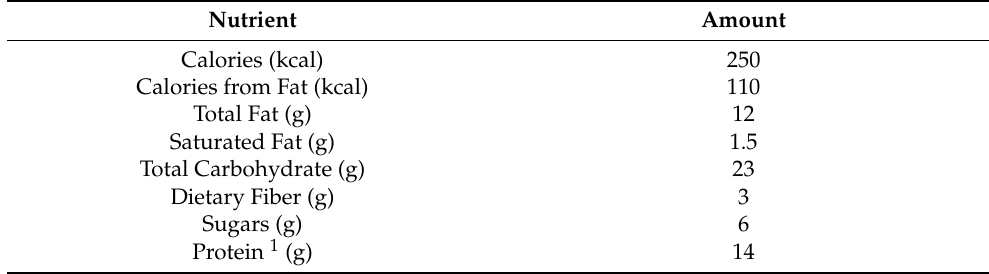
Table 1. Energy and macronutrient contents of one serving (237 mL) of the nutritional supplement. Nutrient Amount Calories (kcal) 250 Calories from Fat